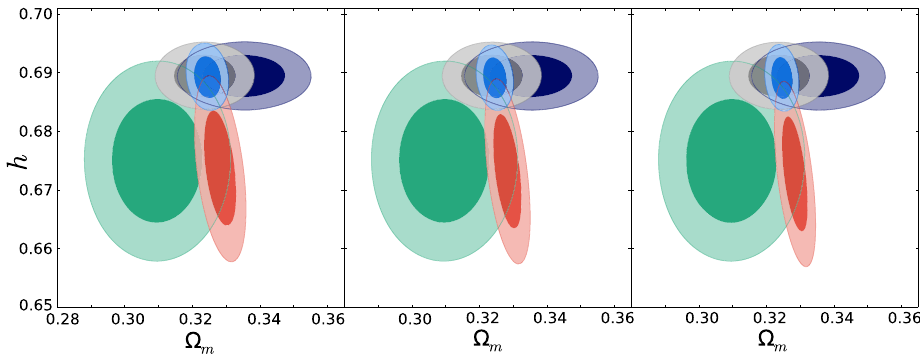
Fig. 4 Λ CDM model; solid contours limit 1 σ regions and clear contours 2 σ region. Purple for the BAO, green for SNe and red for SL data set, gray for SNe + BAO and blue SL + BAO + SNe. First set (left) for 24 years, second (middle) for 28 and third (right) for 32 years